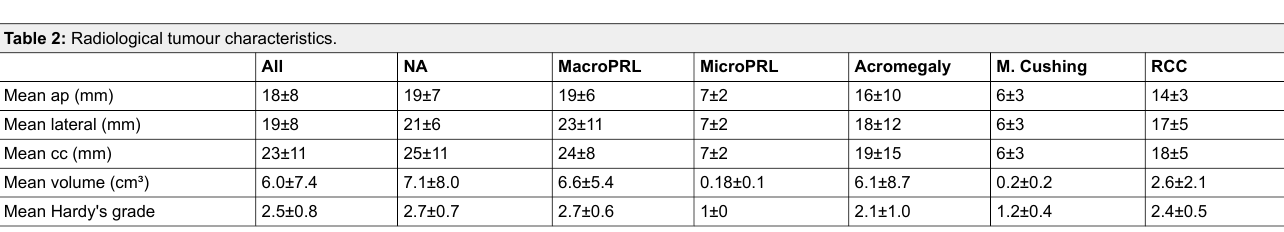
Table 2: Radiological tumour characteristics.